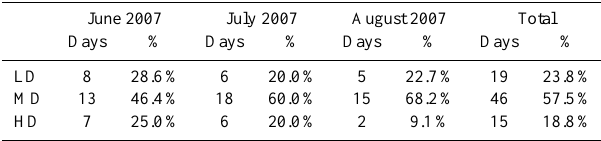
Table 4. Number of days and occurrence frequency for each lake-breeze circulation deformation type over the entire BAQS-Met study period. LD, MD and HD are low deformation, moderate de- formation, and high deformation,